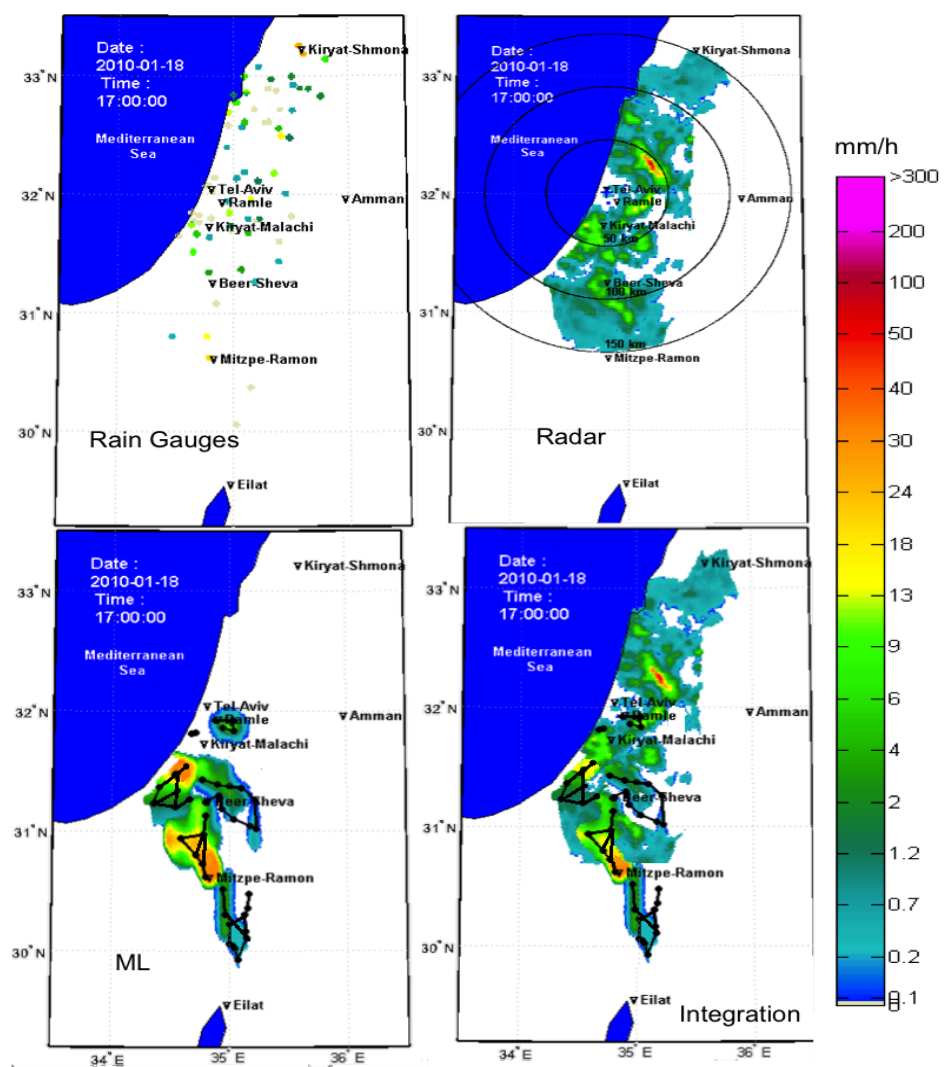
Figure 4. Example of the rain field reconstruction for the 18 January 2010 rain event (event 1) at 17:00IDT (Israel Daylight Time). Top left: Fig. 4. Example of the rain field reconstruction for the 18-Jan-2010 rain event (event(1)) at 17:00. Top left: rain gauges. Top right: radar. Bottom left: ML. Bottom right: the Rain gauges. Top right: Radar. Bottom left: ML. Bottom right: The proposed integration.